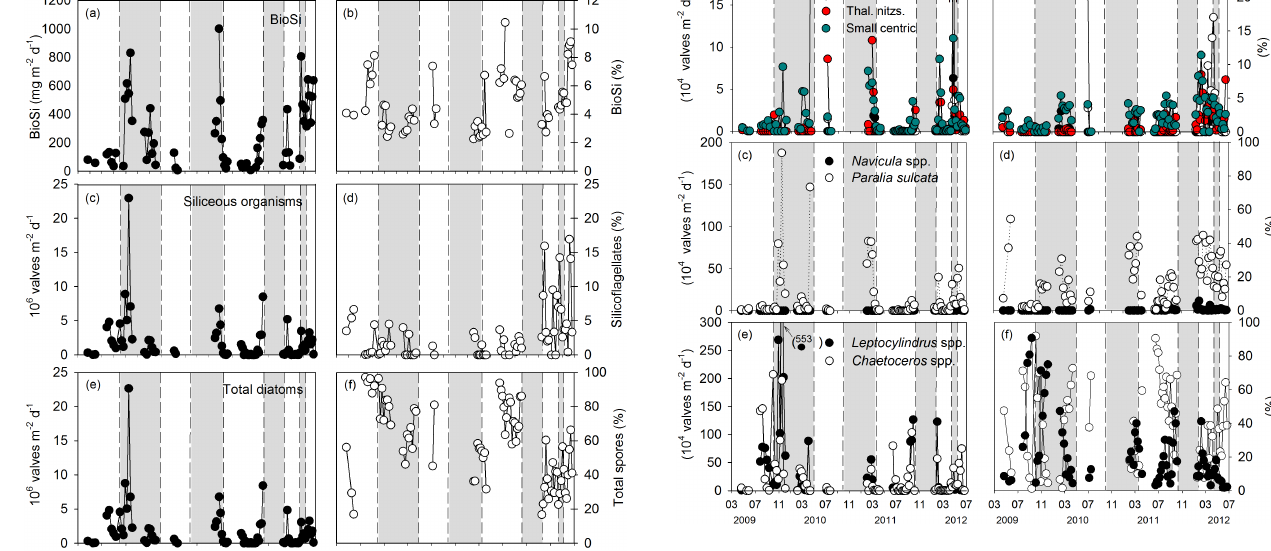
Figure 7. Time series of marine diatoms fluxes (a, c, e) and as- semblages (relative contributions to total marine diatoms b, d, f ) recorded with a PPS 4 / 3 sediment trap at RAIA station. Fossil di- atom species has been classified in three groups in order to com- pare them with water column diatom assemblage. Nitzschia spp: Nitzschia marina ; Pseudo-nitzschia spp: Pseudo-nitzschia pungens ; Thal. Nitzs: Thalassionema nitzschioides . Small centric includes Coscinodiscus marginatus , Coscinodiscus radiatus and Thalas- siosira eccentrica . Upwelling and downwelling periods are high- lighted with white and grey bars, respectively, based on upwelling index and biogeochemical data presented in Zúñiga et al.